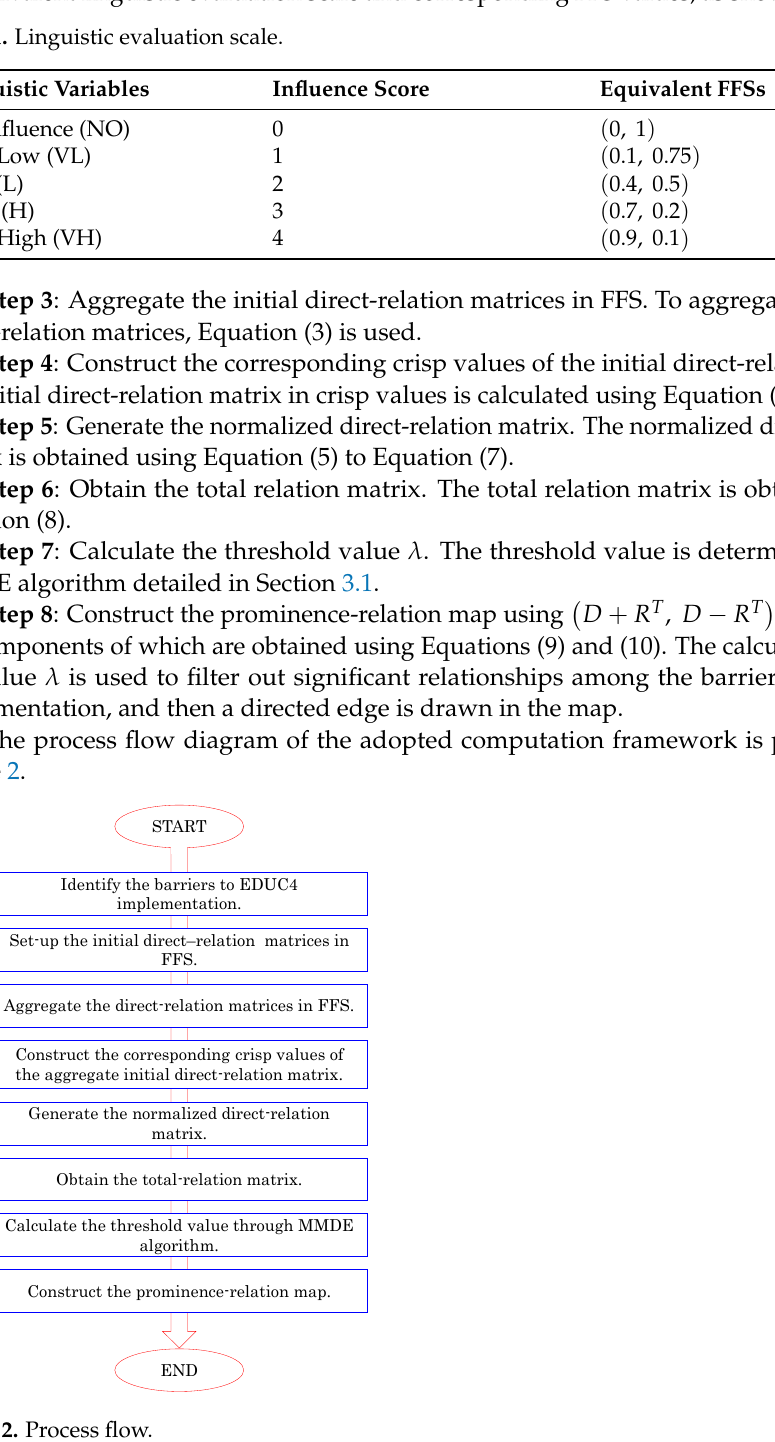
Figure 2. Process